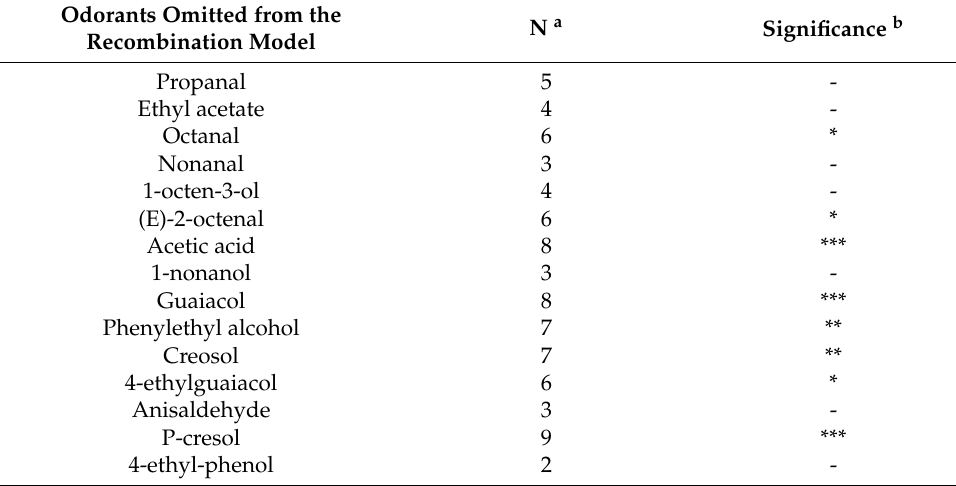
Table 4. Omission tests from complete recombination model.